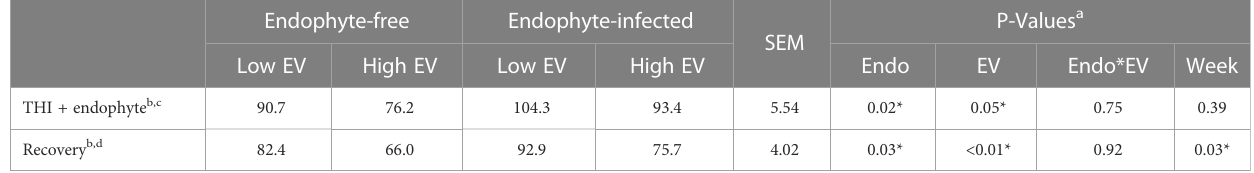
TABLE 8 Experiment 2 average weekly water consumption in response to endophyte (Endo) and exit velocity (EV) treatments.